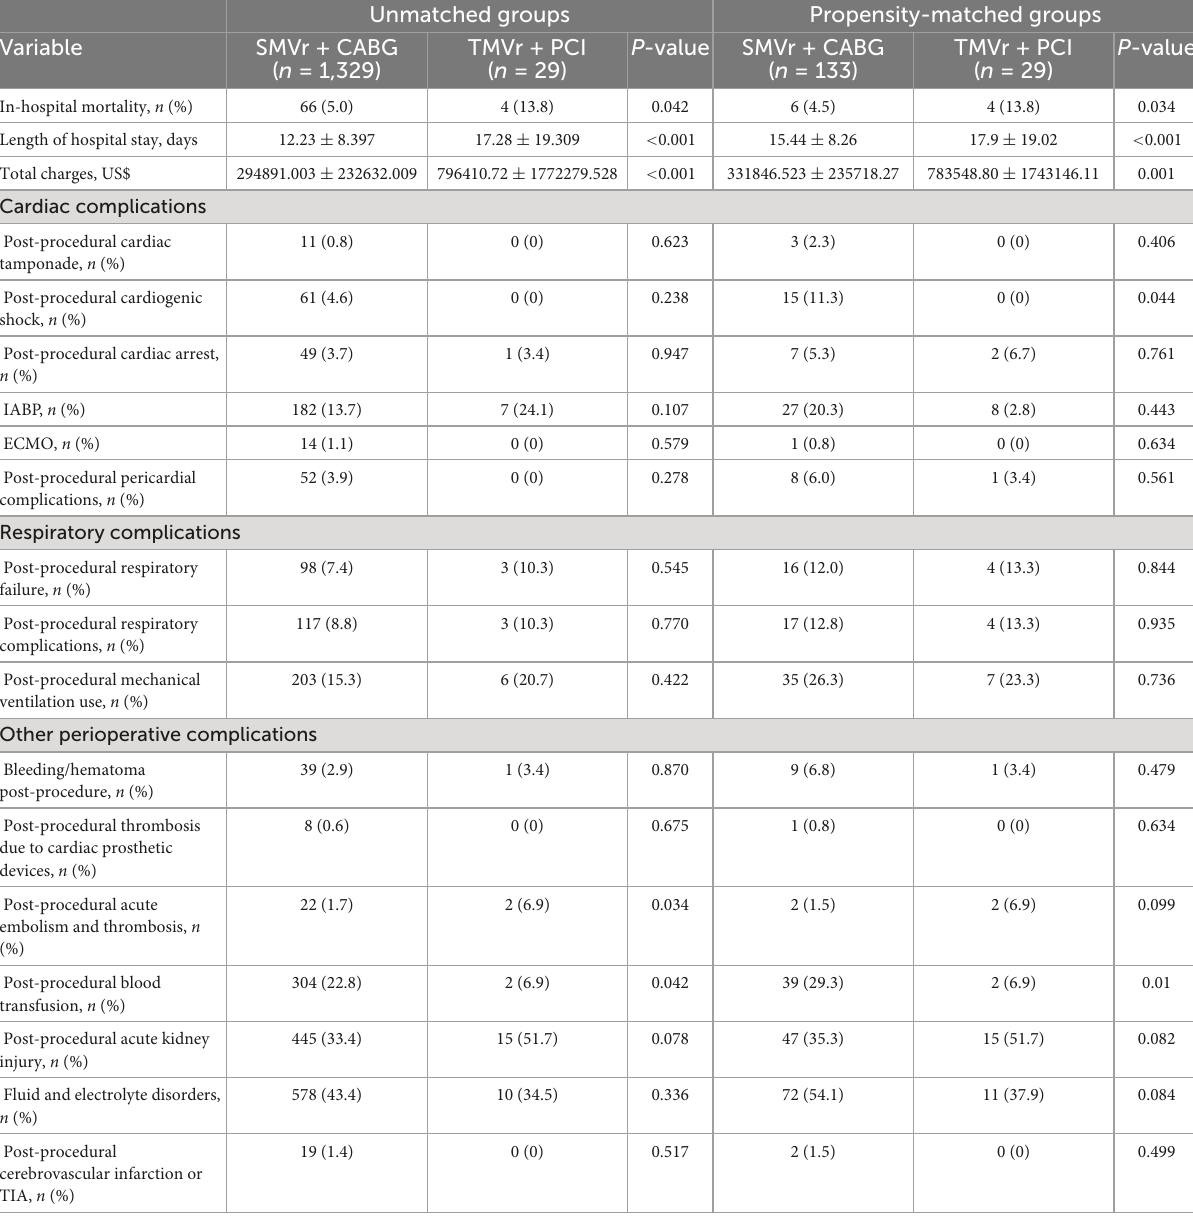
TABLE 2 Clinical outcomes in patients who underwent SMVr + CABG and TMVr + PCI (2016–2018). Unmatched groups Propensity-matched